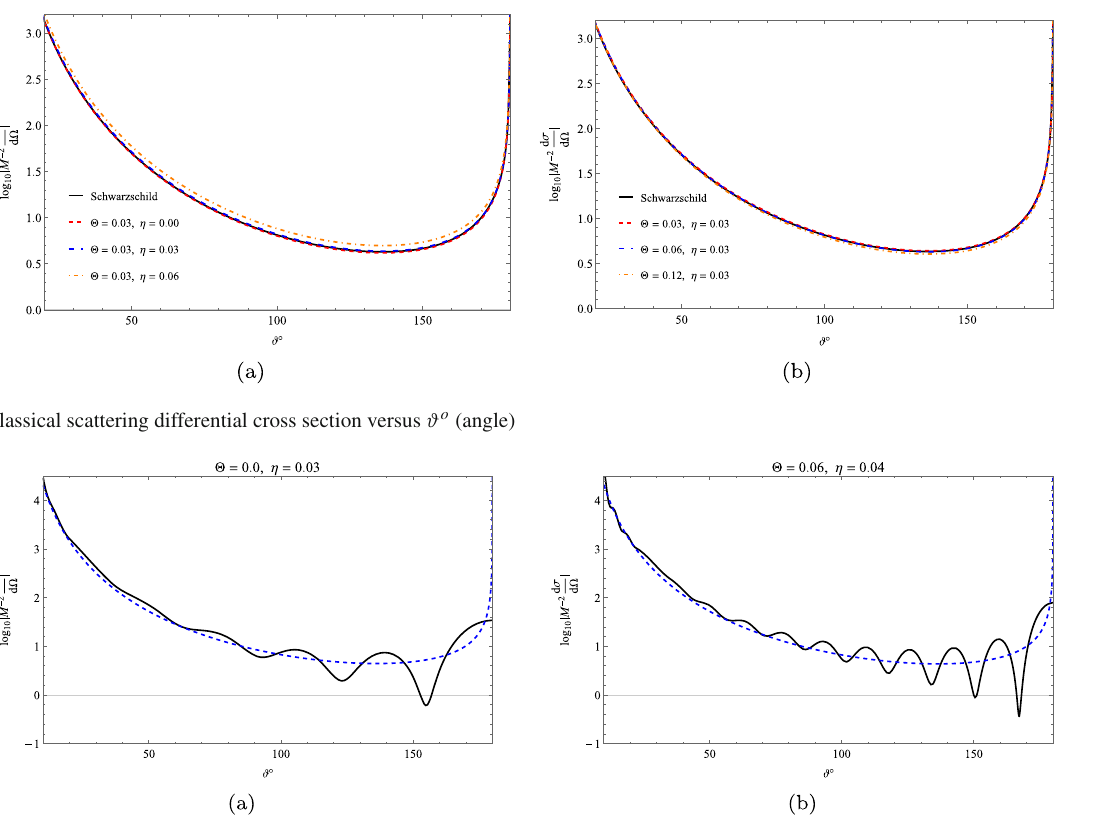
Fig. 15 Classical and numerical scattering differential cross section versus ϑ o (angle). For the numerics we assume M ω = 1 in ( a ) and M ω = 2 in ( b